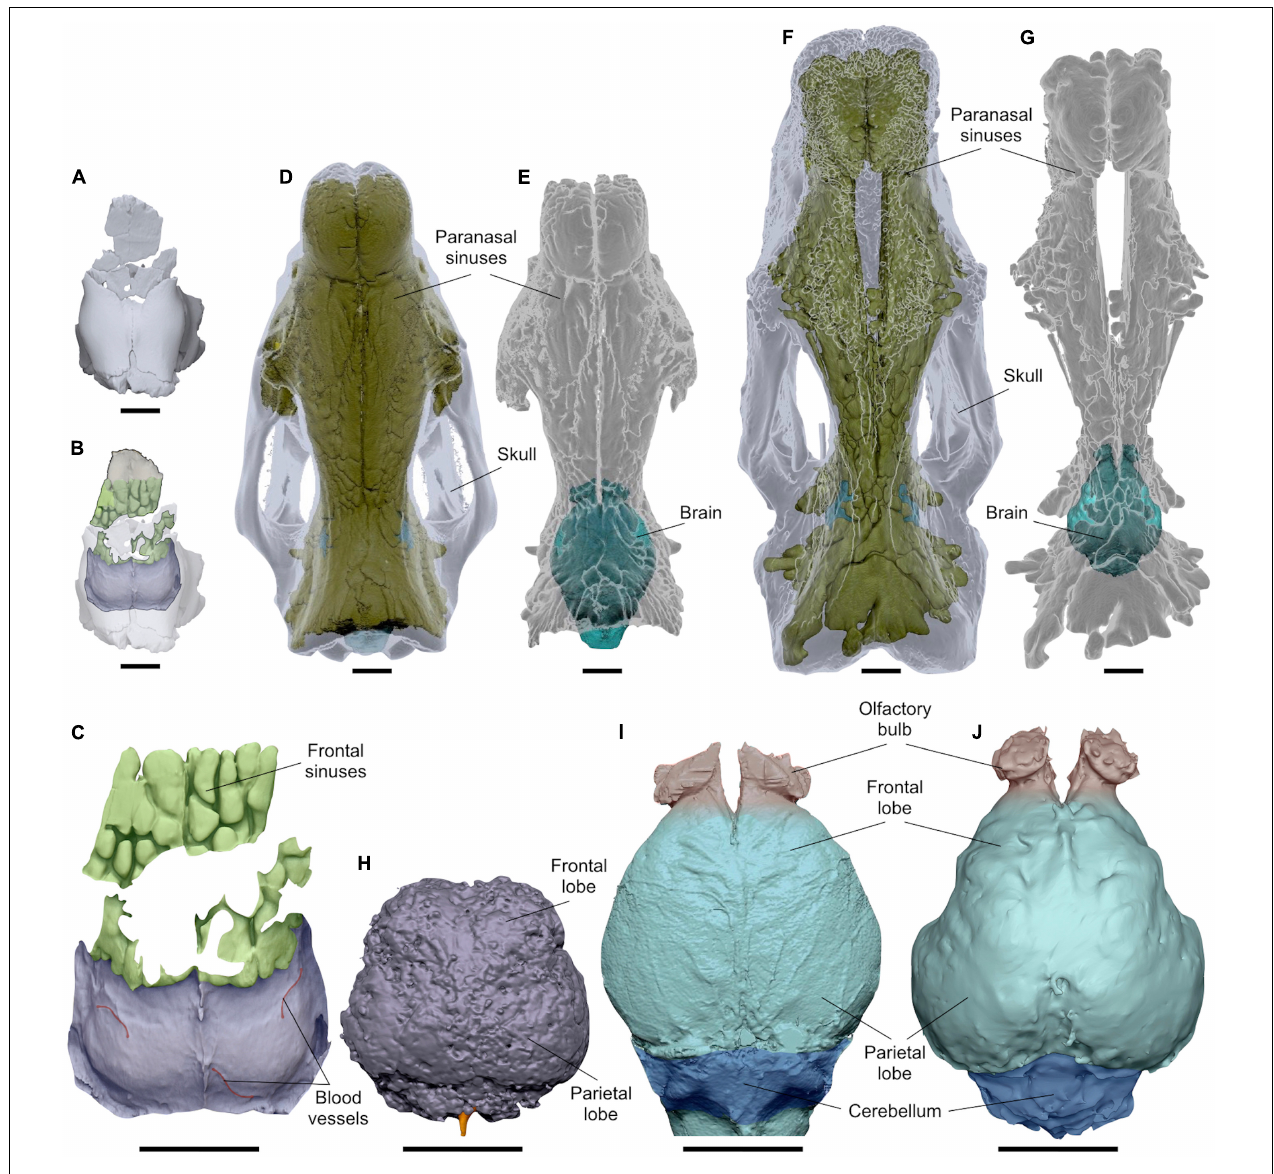
FIGURE 5 | Comparative CT images in dorsal view of the paranasal pneumatization and brain morphology of MPND1083 (A–C) , Diceros bicornis (D,E) , and Ceratotherium simum (F,G) . Digitalized natural endocast MPND1083 (H) ; brain endocasts of D. bicornis (I) ; and C. simum (J) . Sale bars 5 cm.